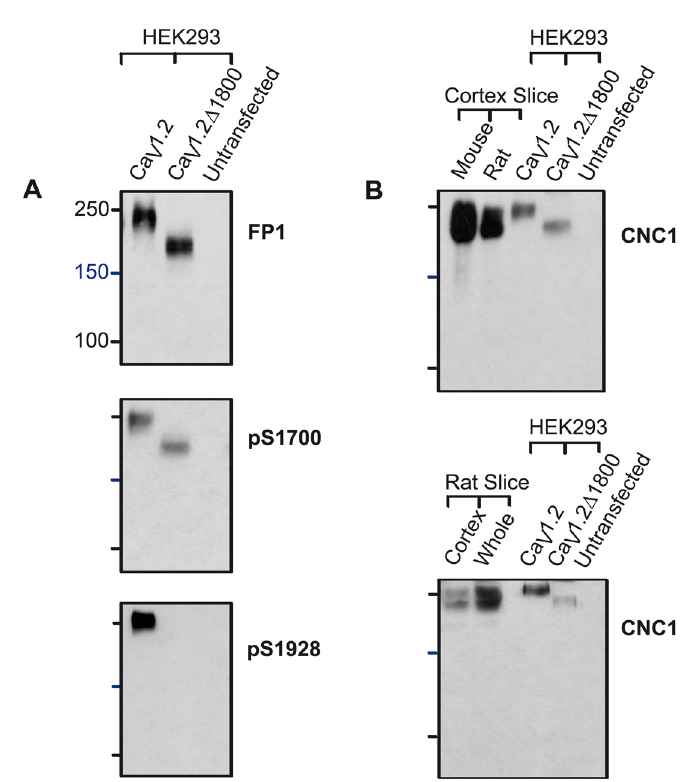
Figure 4. Mouse and rat α 1.2 short forms co-migrate with α 1.2 truncated at residue 1800 in the middle of the c-terminus. HEK293T 1 1 cells were transfected with full length or truncated ( ∆ 1800) α 1.2 plus α and β . HEK293T cells and rat and mouse brain slices were δ 1 2 1 2a extracted with 1% Triton X-100 before immunoprecipitation of α 1.2, SDS-PAGE in gels polymerized from 8% acrylamide, and immunoblotting 1 with the indicated antibodies. ( A ) The full length form of α 1.2 expressed in HEK293 cells migrated with an apparent M of 250 kDa and is 1 R detected by FP1, pS1700 and pS1928. Truncated ∆ 1800 α 1.2 migrated with an apparent M of 210 kDa and is detected by FP1 and pS1700 1 R but not pS1928. ( B ) The α 1.2 short and long form appear only partially resolved because the weak α 1.2 signals in HEK293 cell samples 1 1 required long exposure times. The upper band as detected by CNC1 after FP1 immunoprecipitation from rat and mouse forebrain slices and cortical slices co-migrated with the full length form of α 1.2 expressed in HEK293 cells, while the lower band co-migrated with the truncated 1 ∆ 1800